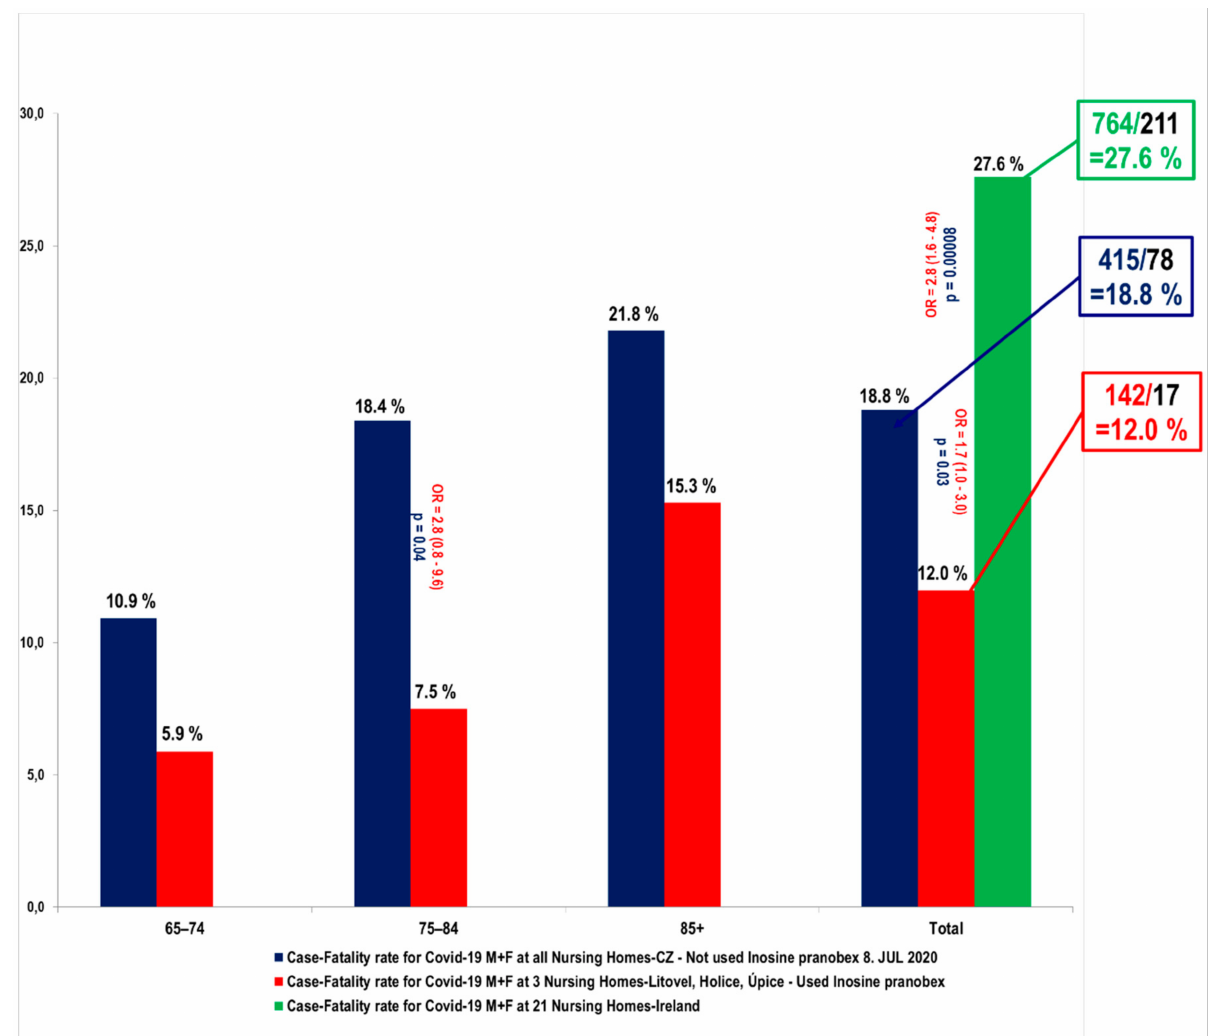
Figure 1. Comparison of the case fatality rate (CFR) for COVID-19 of the residents of three nursing homes (142/17) to the CFR from all nursing homes in the Czech Republic (415/78) and to the CFR of 21 NH in Ireland